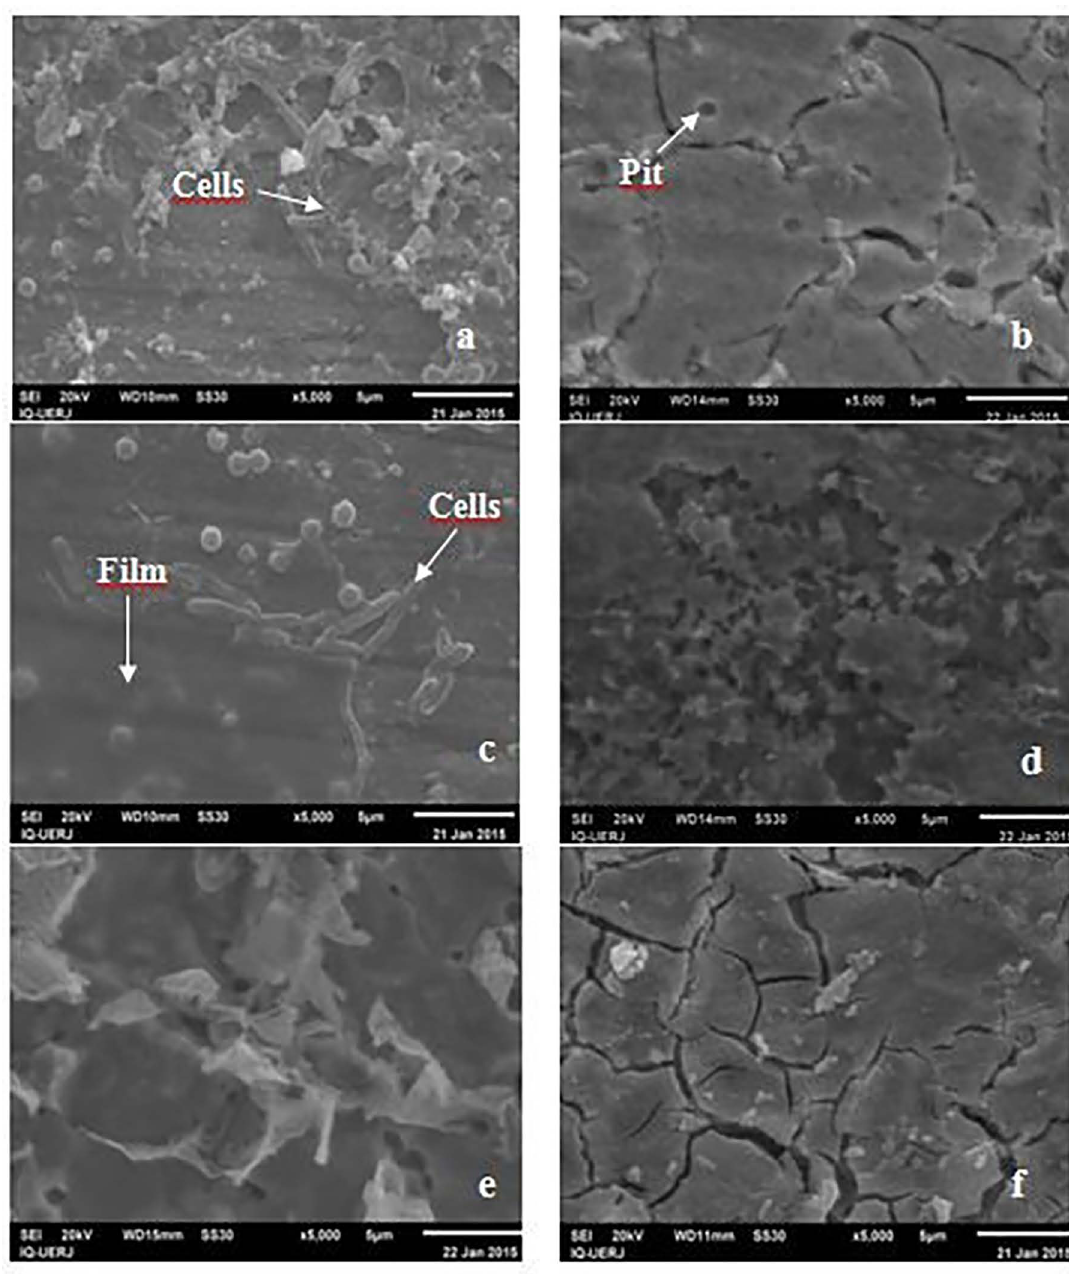
Figure 3. SEM images for the biofilm developed on carbon steel AISI 1020 surface in modified Baar’s medium for 7 days. (a) Biofilm without biocides (control); (b) The same coupon (a) after biofilm removal (control); (c) Biofilm with garlic oil; (d) The same coupon (c) after biofilm removal; (e) Biofilm with glutaraldehyde; (f) The same coupon (e) after biofilm removal